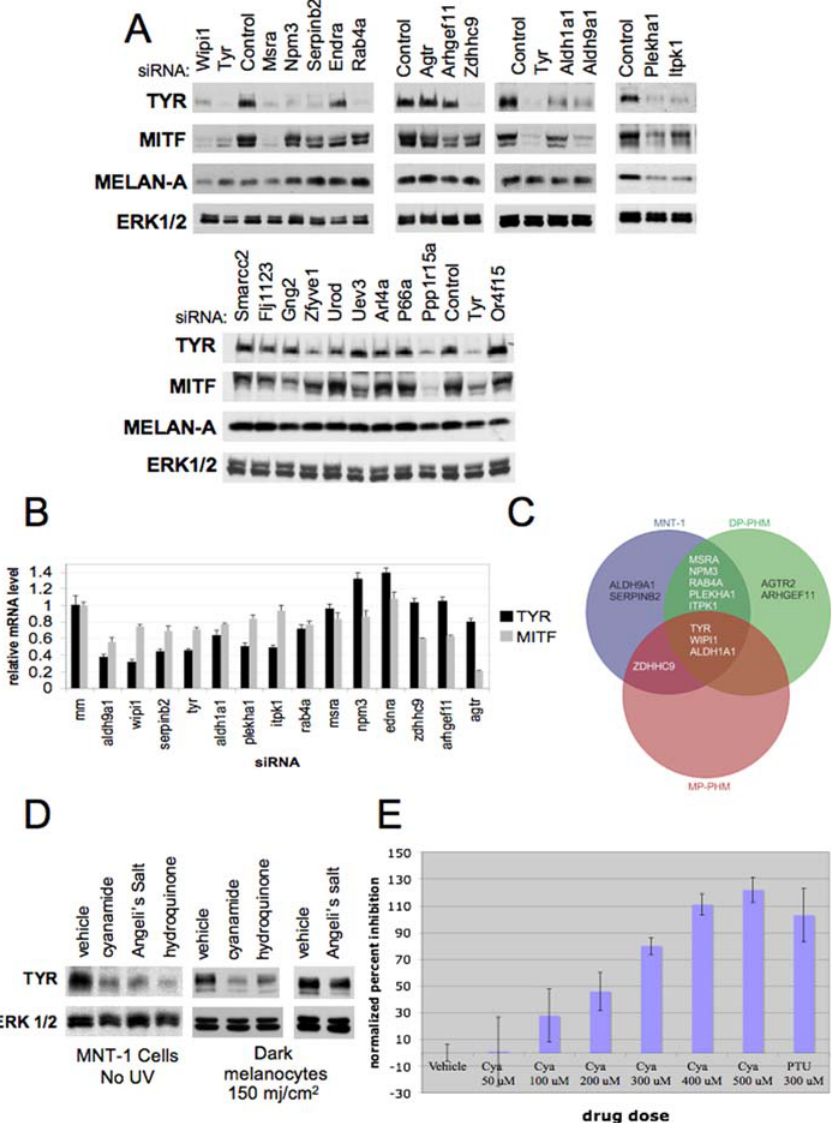
Figure 2. Novel, pharmaceutically-tractable melanogenesis gene networks converge on tyrosinase expression. A) 4 days post transfection with the indicated siRNAs, MNT-1 whole cell lysates were prepared and analyzed by immunoblot for the indicated proteins. A non- targeting siRNA was used as a transfection control (Control). ERK1/2 is shown as a loading control. B) Those siRNAs that inhibited tyrosinase accumulation were examined for consequences on tyrosinase and MITF gene expression by quantitative RT-PCR. 72 hours post transfection with the indicated siRNAs, equal numbers of MNT-1 cells were lysed and cDNA was prepared using a Cells to Ct kit (Ambion). Taqman qRT PCR assays (Applied Biosystems) for tyrosinase and MITF was utilized to identify siRNAs that impacted tyrosinase and MITF expression. C) The indicated siRNAs, targeting novel pigmentation genes identified in the MNT-1 screen, were tested for consequences on tyrosinase accumulation in darkly pigmented and moderately pigmented primary human melanocyte cultures 6 days post-transfection. The results presented here is a venn diagram of the data presented in Figure S5 demonstrating that we have identified pigment regulators that differentially impact pigment production in different genetic backgrounds. D) Pharmacological inhibition of Aldh activity impacts tyrosinase protein accumulation. MNT-1 cells (left panel) and primary melanocyte cultures (right panels) were exposed to 5 m M Aldh inhibitors (cyanamide or Angeli’s salt) or the tyrosinase inhibitor hydroquinone [15] for 72 hours as indicated. 24 hours post-treatment, cultures were exposed to UV-B at the doses indicated. Tyrosinase and ERK1/2 levels were assessed by immunoblot. MNT-1: Angeli’s salt (5 m M), cyanamide (5 m M), or hydroquinone (5 m M); primary melanocytes: Angeli’s salt (50 m M), cyanamide (100 m M), hydroquinone (1 m M). E) Aldh inhibitors impair melanogenesis in primary human melanocytes. Darkly pigmented melanocytes were cultured for seven days in the presence of the indicated dosed of cyanamide (cya), vehicle, or PTU. PTU is the most potent currently known in vitro pigment inhibitor in primary melanocytes [43]. Subsequently, cells were lysed in CellTiter-Glo and the luminescence and absorbance values were used to calculate inhibition of pigmentation as in Figure 1A.